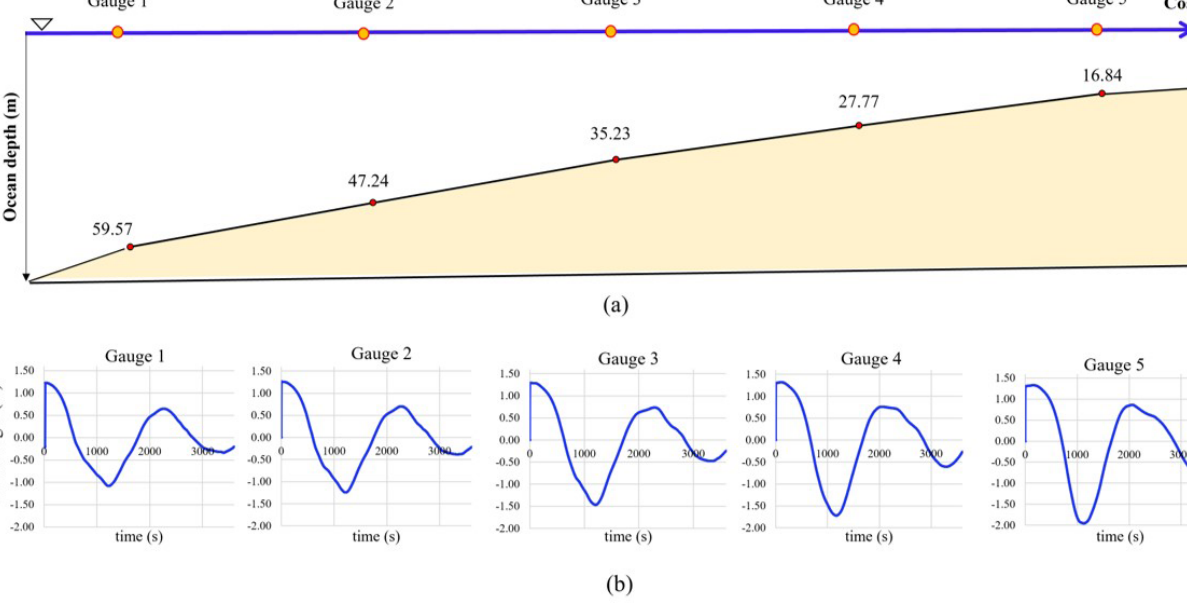
Figure 25. (a) Ocean depths at the gauge locations (top) and (b) wave height distribution obtained during the simulation